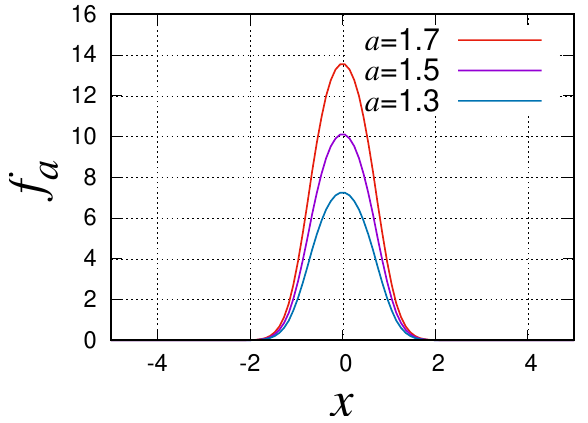
Figure 2. The function f a ( x ) in Equation (36) is plotted for a = 1.3, 1.5, and